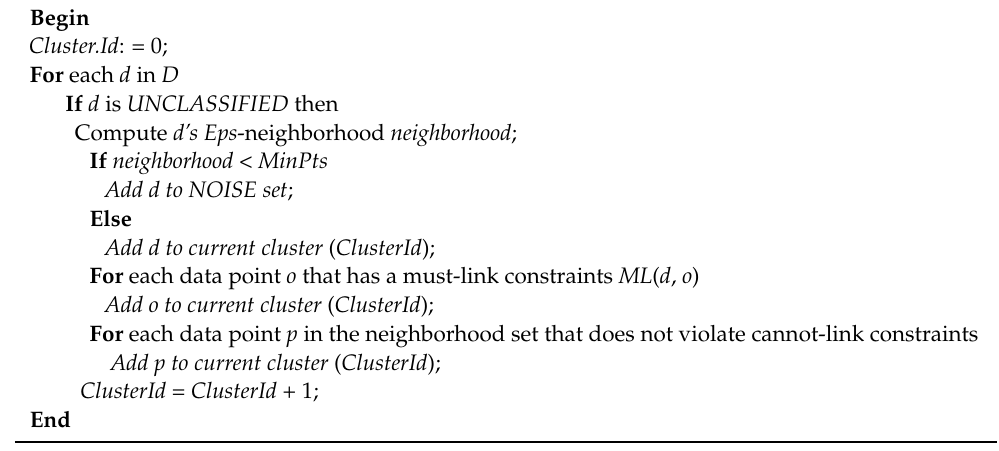
Algorithm 2 Semi-DBSCAN ( D, ML, CL, MinPts, Eps )